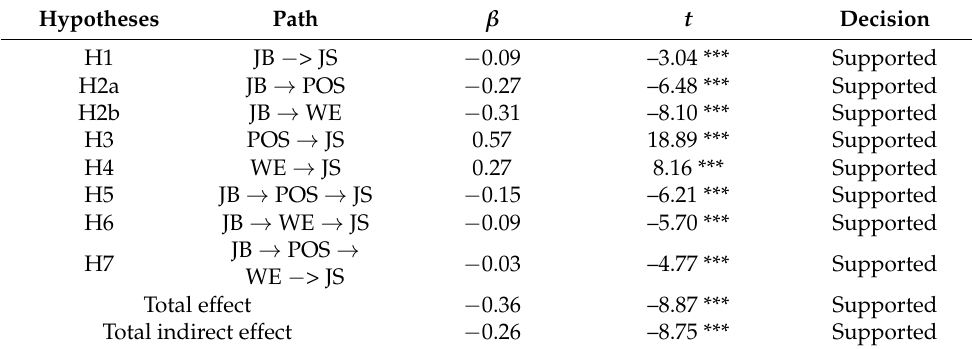
Table 8. Results of the hypothesis test.